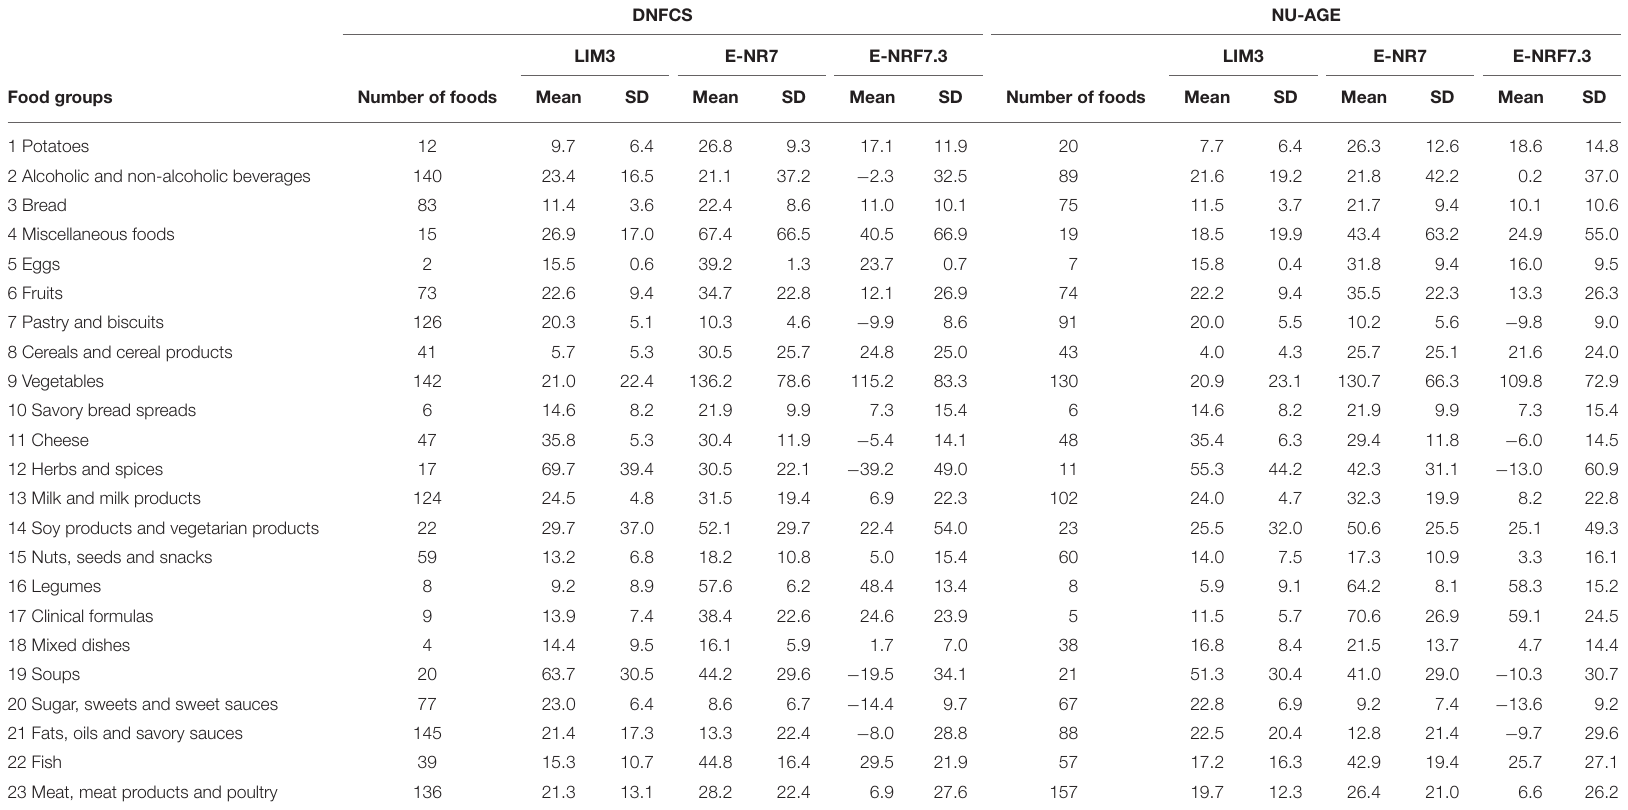
TABLE 7 | Mean E-NRF index scores per food group, calculated per 100 kcal of foods consumed within DNFCS ( n = 735) and NU-AGE ( n =